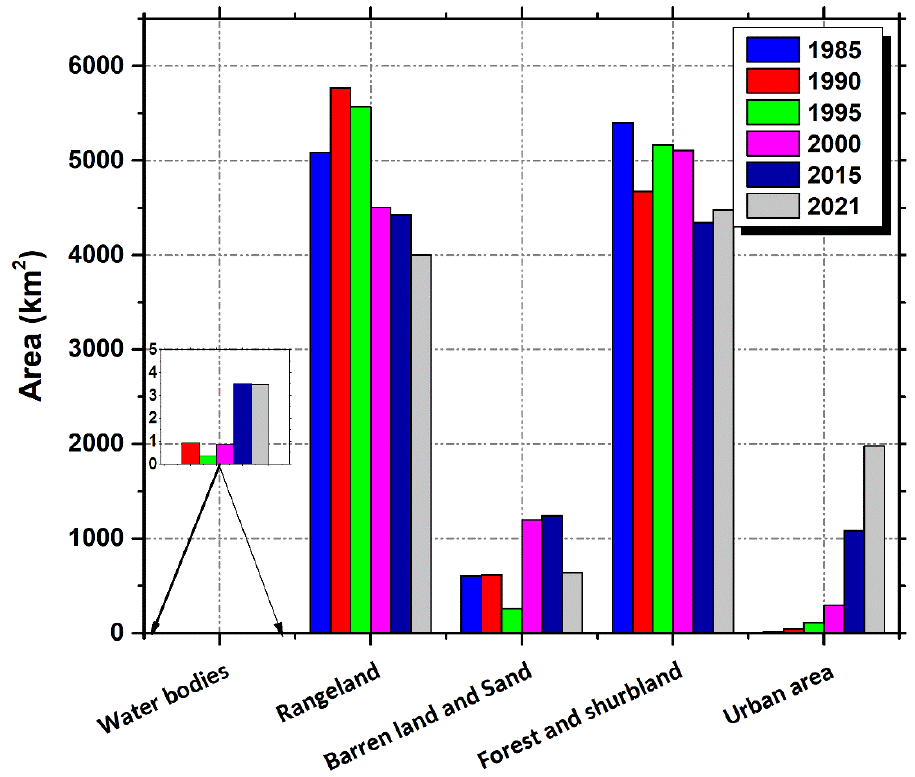
Figure 5. Change in different land cover classes for the years: 1985, 1990, 1995, 2000, 2015, and 2021. The LULCC map analysis of the year 1985 revealed that the rangeland area was esti- mated to be around 5082 km 2 (47.55%). This area has increased by 689 km 2 to an area of